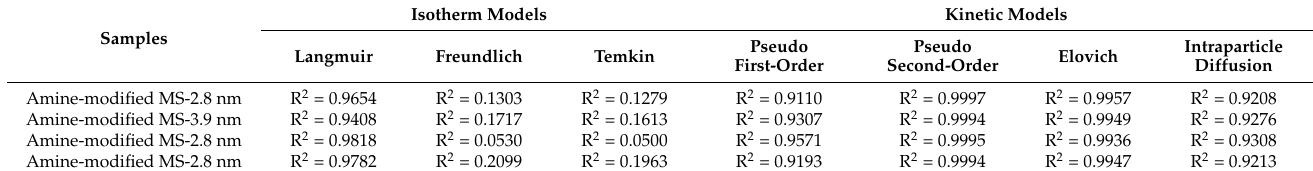
Table 2. Correlation coefficients against each isotherm models and kinetic models.